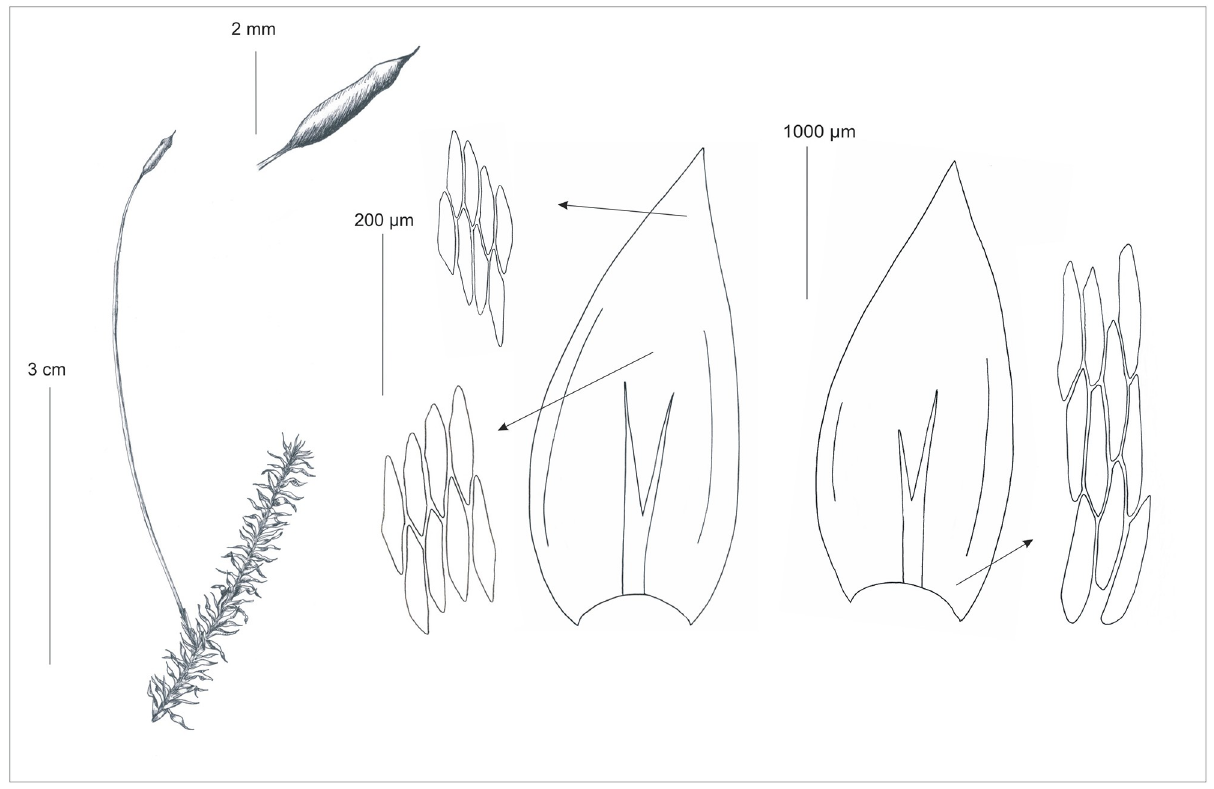
Fig 2. Gametophyte and sporophyte as well as stem leaves and cells from individual zones of the P . longisetum . Drawn from the type material (PC 132572 , H-SOL 1563011 ) G. J. Wolski & A. Cienkowska.